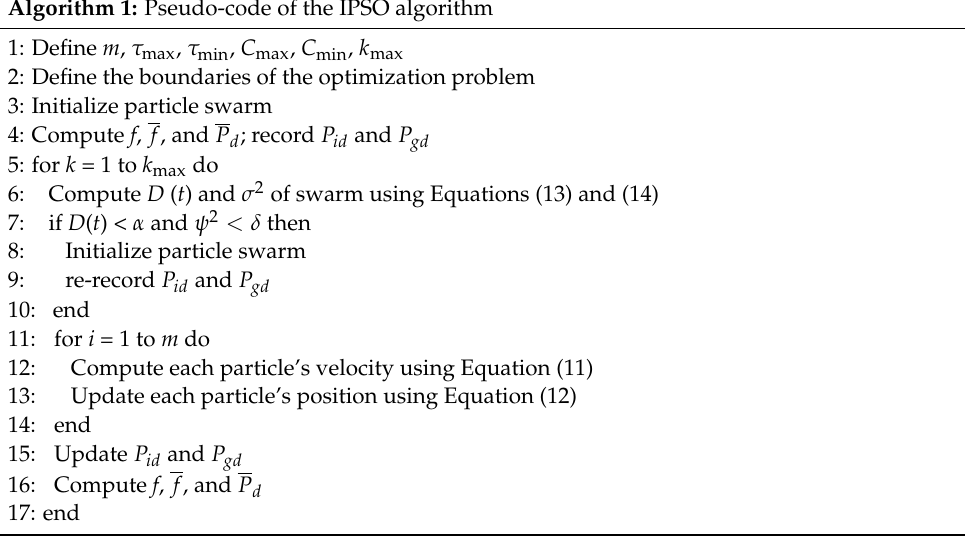
Algorithm 1: Pseudo-code of the IPSO